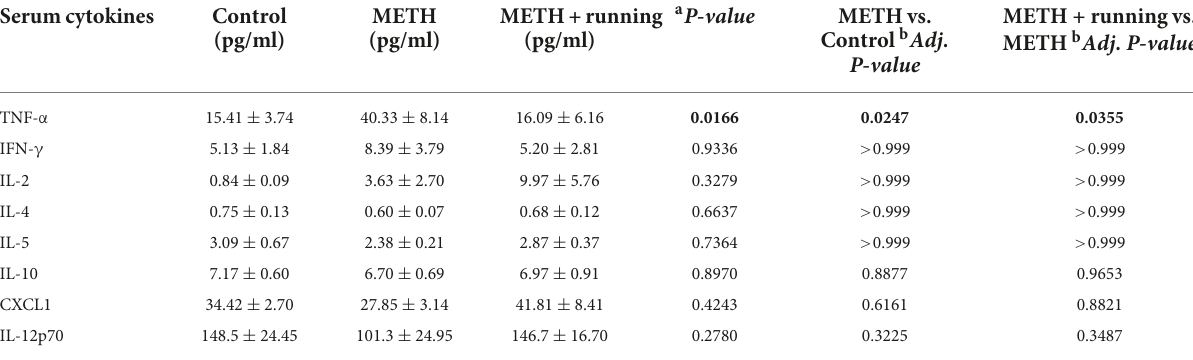
TABLE 2 Treadmill exercise regulate the levels of serum cytokines in METH acute withdrawal mice. Serum cytokines Control